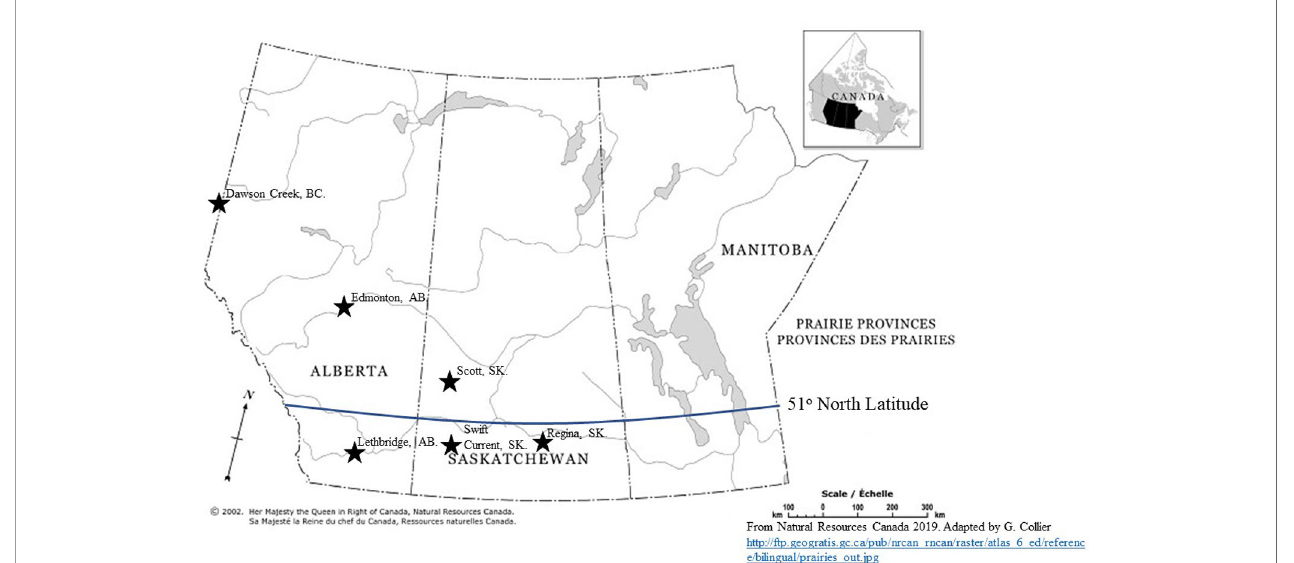
FIGURE 1 | Geographical distribution of test locations for the assessment of ultra-early wheat planting in western Canada 2015 to 2018. (The Atlas of Canada — Natural Resources Canada.